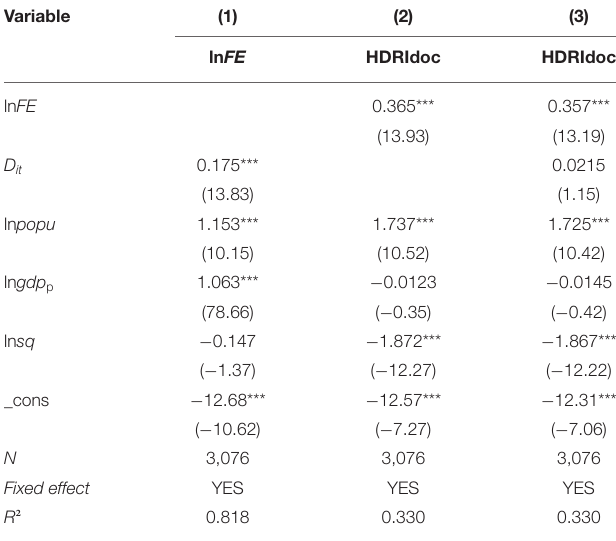
TABLE 9 | Regression results of mediation